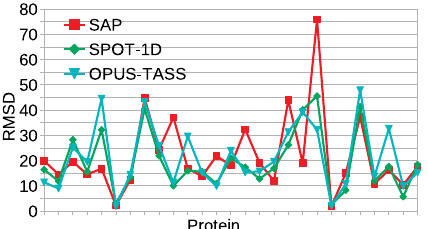
Figure 6. RMSD values for SAP, SPOT-1D, and OPUS-TASS on TEST2018 proteins.